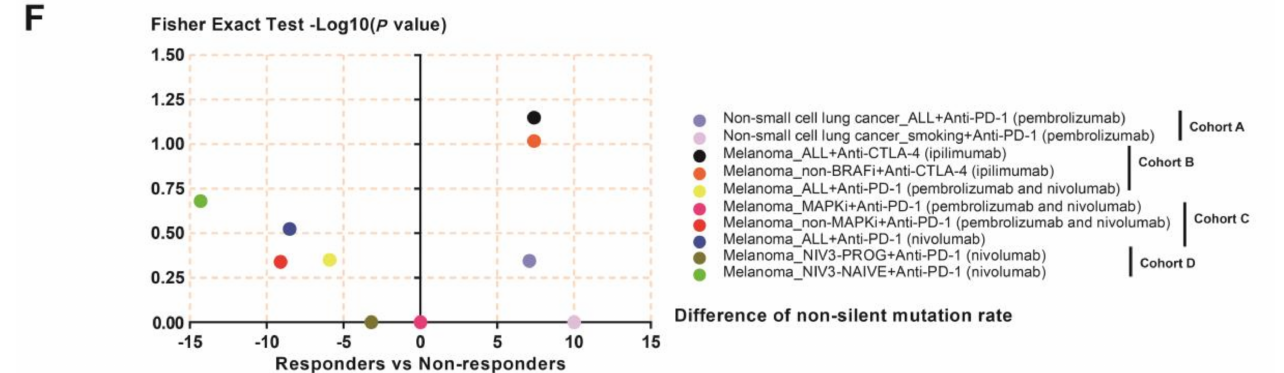
Figure 10. NEIL3 was correlated with chemotherapy sensitivity and ICB response. The association of NEIL3 expression level with chemotherapy sensitivity in ( A ) CGP; ( B ) CTRP; and ( C ) CCLE databases. ( D ) The CARE score of the relationship of NEIL3 and chemotherapy resistance in three